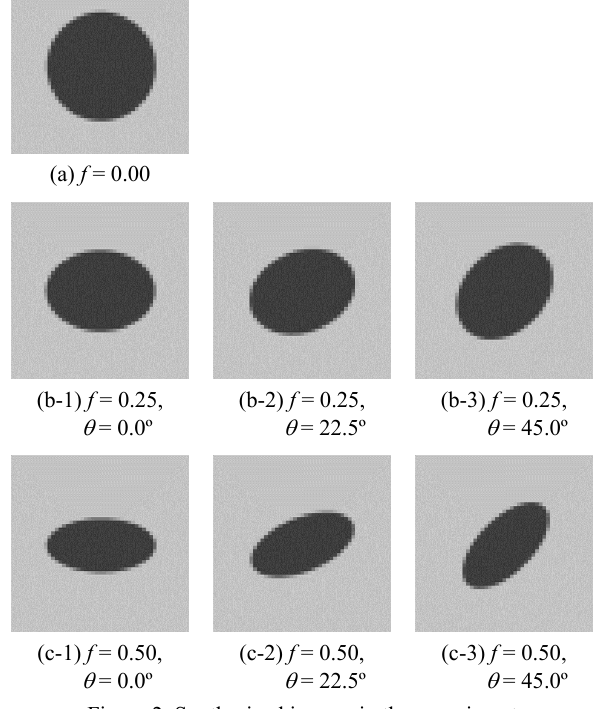
Figure 2. Synthesized images in the experiment 2.3 Measurement accuracy Measurement accuracy was measured by a root mean squares